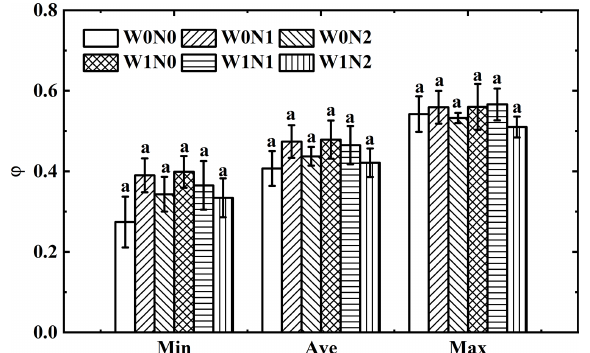
Figure 5. Variations in ϕ calculated by Eq. (9) using the minimum (Min), average (Ave) and maximum (Max) values of δ 13 C air across water (W) and nitrogen (N) additions. The box represents the mean value of four replicates with error bars denoting the standard error